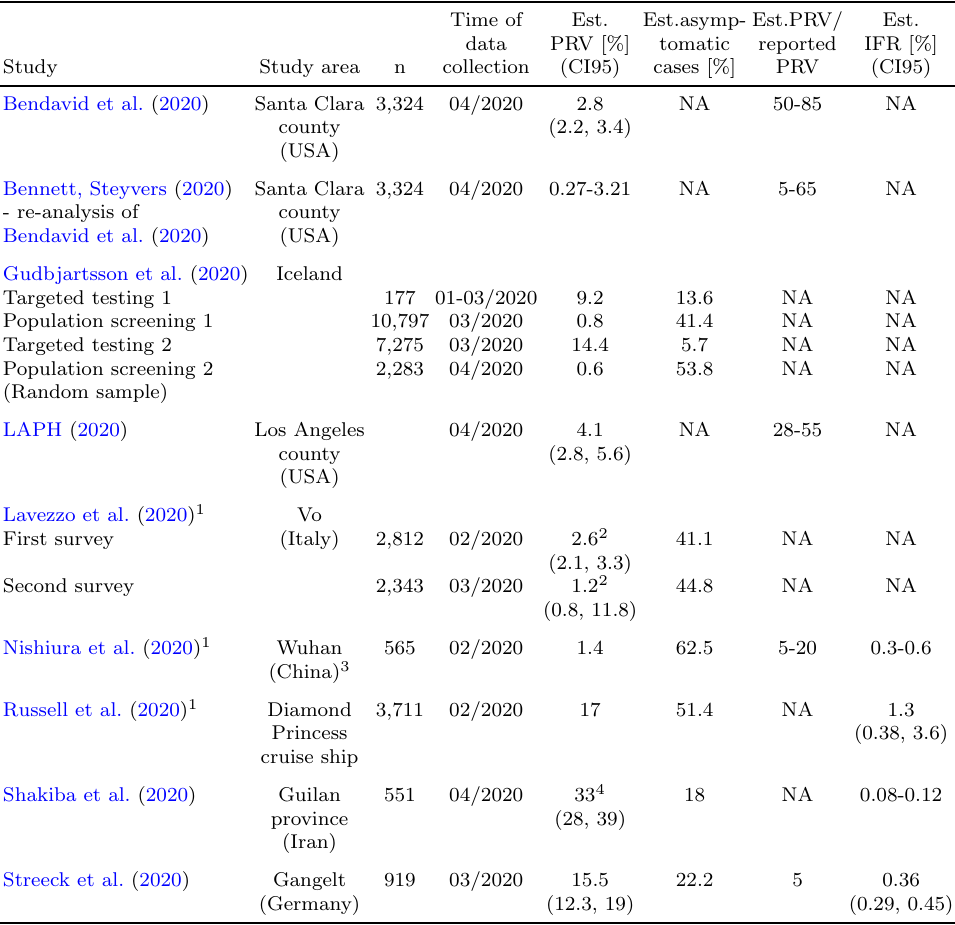
Table 13: Studys on unreported cases and/or IFR of SARS-CoV-2/COVID-19 Time of